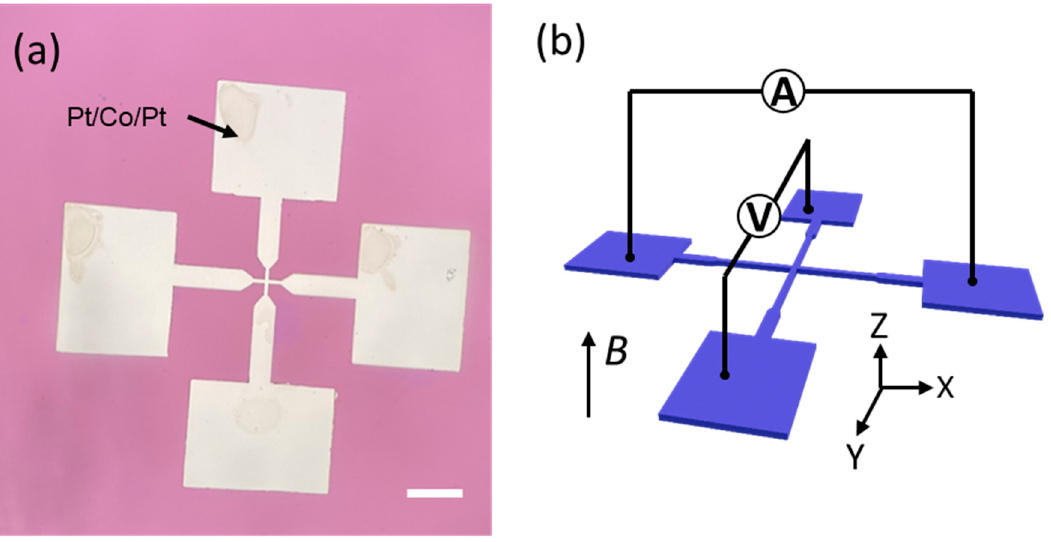
Figure 3. ( a ) Optical image of Pt/Co/Pt heterostructure device with Hall bar. The scale bar is 20 μ m. ( b ) Schematic diagram of the measurement device for Hall and longitudinal resistivity.